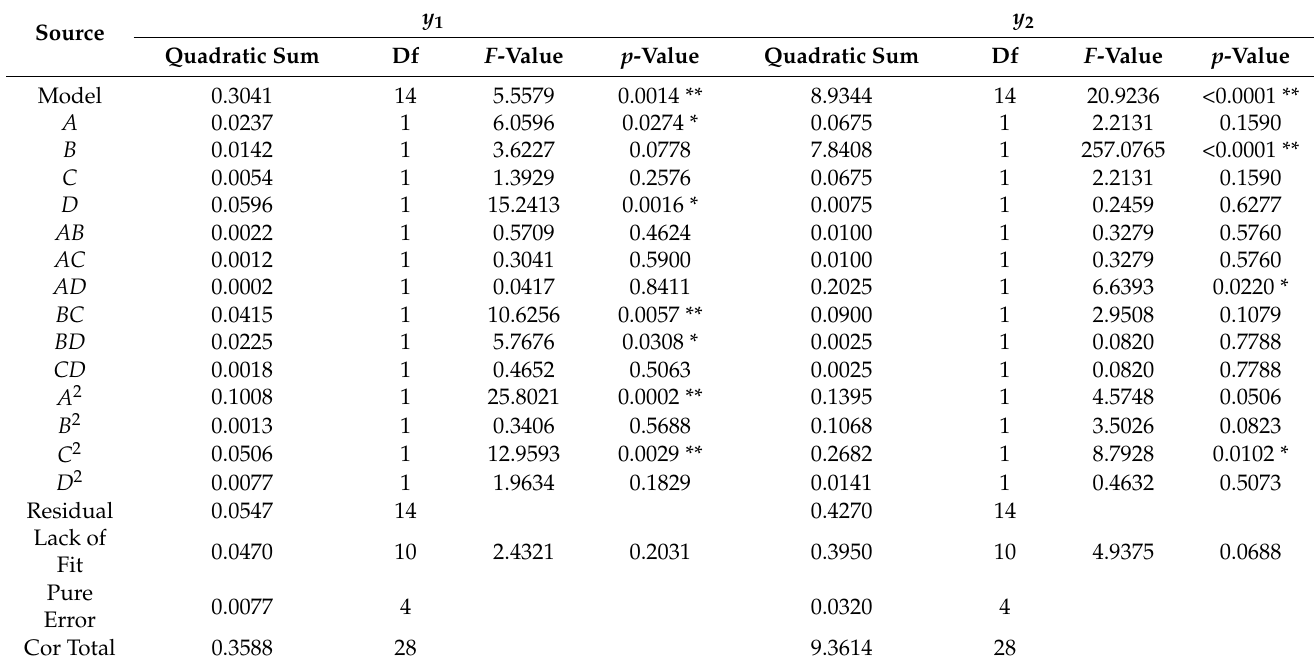
Table 5. Analysis of variance for cross-factor